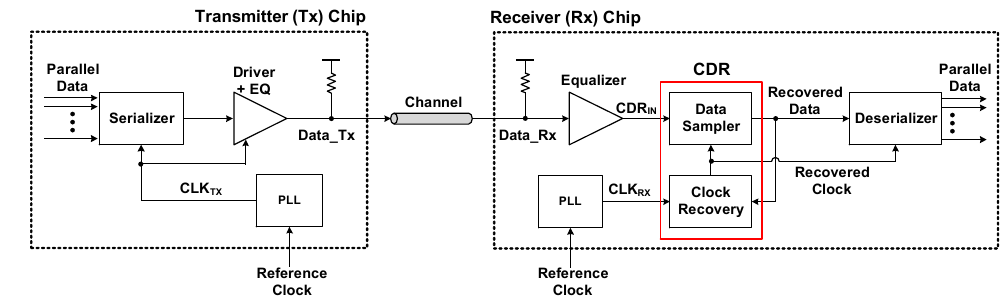
Figure 1. Typical high-speed serial-link SerDes architecture.